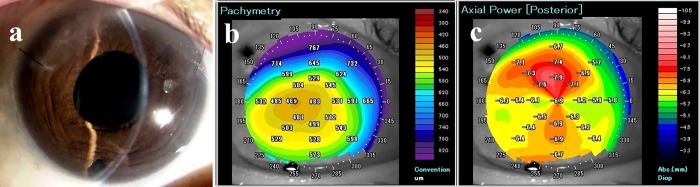
A patient with poor visual acuity and high posterior color grade 3 months after DMEK.(A) Slit-lamp photograph shows high transparency 3 months after DMEK. (B) Pachymetry after DMEK shows that the central corneal thickness is about 480 μm, which is considerably thinner than a healthy cornea. (C) Posterior map using AS-OCT after DMEK. Three months postoperatively, AS-OCT shows rapid improvement in corneal edema after DMEK. However, despite the clear cornea after DMEK, the visual acuity is 20/40. In this case, the posterior color grade is relatively high (grade 2). The figure demonstrates the characteristically irregular topography and increased irregular astigmatism at the posterior corneal surface in eyes with relatively poor visual acuity after DMEK. Abbreviations: AS-OCT, anterior segment optical coherence tomography; DMEK, Descemet’s endothelial membrane keratoplasty.